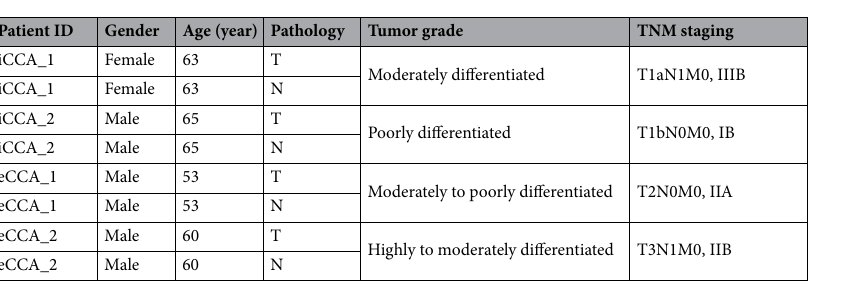
Table 1. Clinical characteristics for enrolled patients. T tumor specimen, N noncancerous